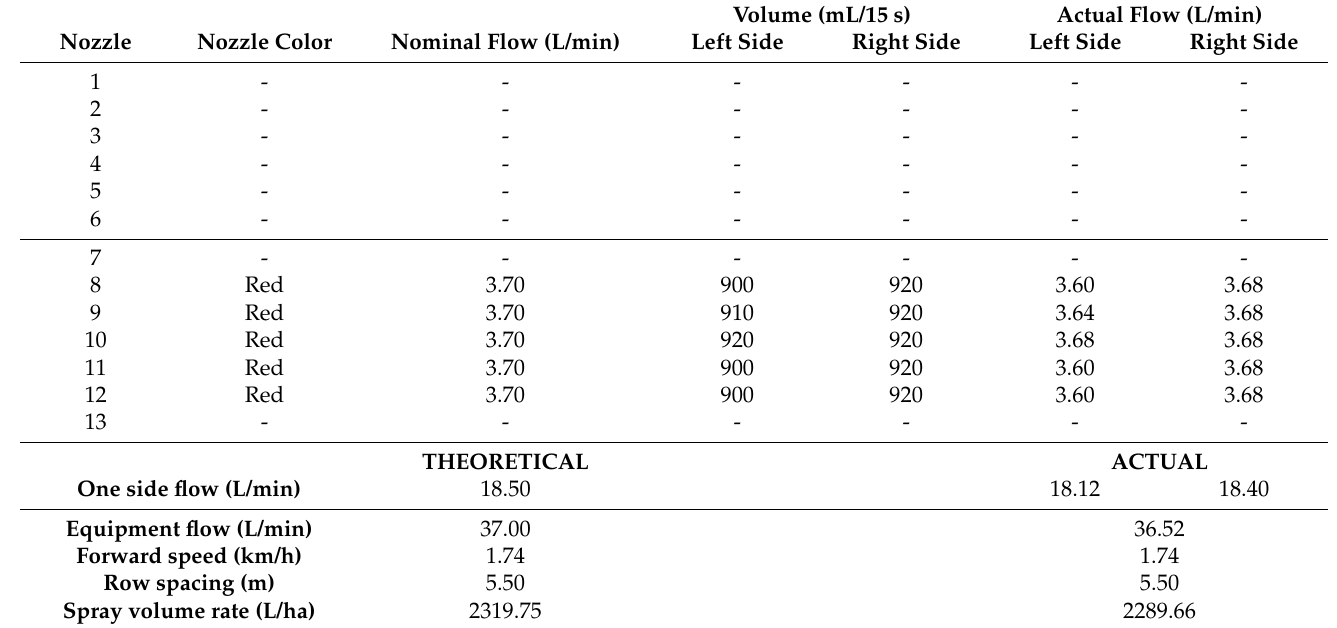
Table A23. Selection and calibration of nozzles for the C1 sprayer, with the following configuration: Adjusted to the vegetation/High & Low fan speed/High spray volume rate/Drift-reducing nozzles (Coarse)/Pressure: 16 bar.